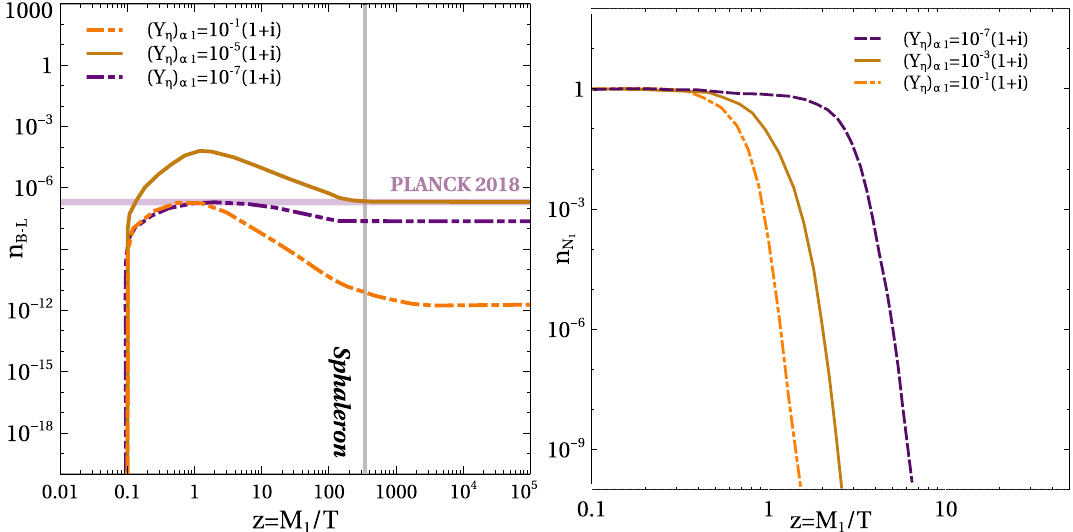
Fig. 5 Comoving density of B-L asymmetry (left panel) and comov- parameters used are M 1 = 45 TeV, M 2 = 450 TeV, m η = 5 TeV = 4 TeV. The horizontal line in left panel plot denotes the M 1 and M Z (right panel) with z = ing number density of N R for different B − L 1 required B − L asymmetry to generate for observed baryon asymmetry T − L gauge coupling relevant for Leptogenesis are taken ( Y η ) α (Planck 2018) after sphaleron 1 . The B to be g BL = 10 − 3 and ( Y η ) α 2 = 10 − 1 ( 1 . 1 − i ) . The other important